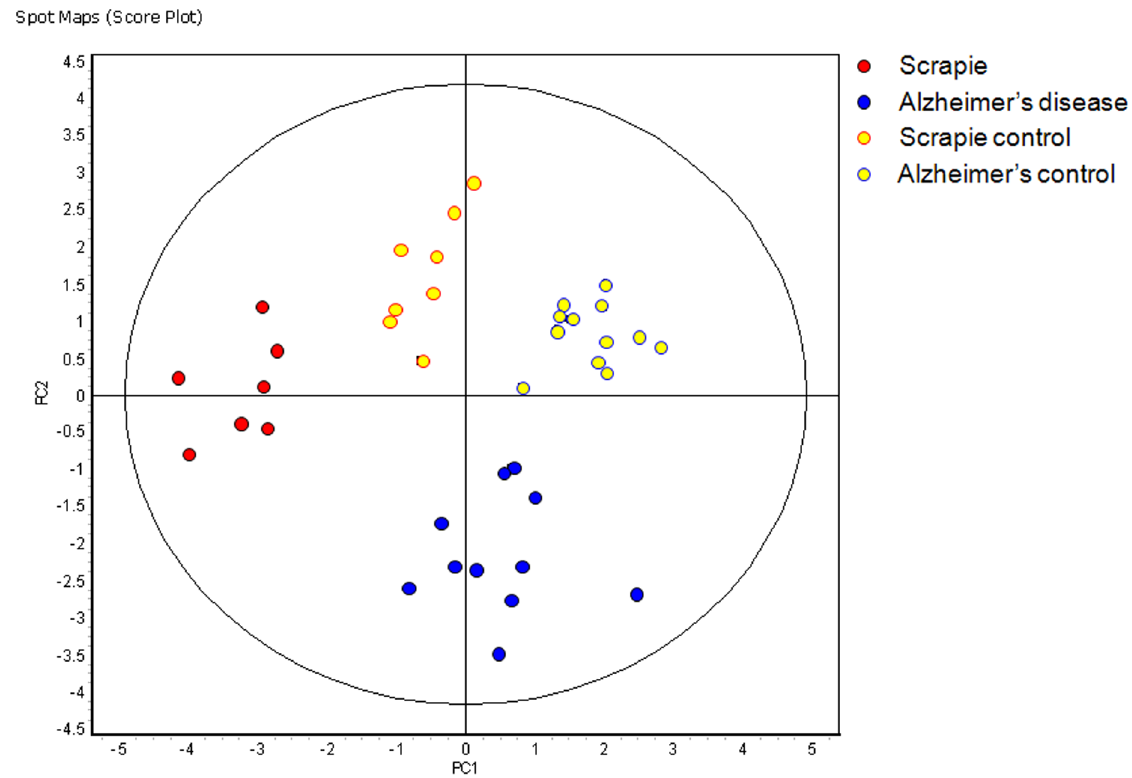
Figure 4. Principle component analysis of the 169 feature classifier applied to the 7 scrapie infected (red) and the 8 corresponding scrapie control samples (yellow with red boarder) obtained from 4 infected and 4 control mice at 15 and 17 weeks post infection combined with the 11 Alzheimer’s diseased (blue) and the 12 corresponding Alzheimer’s disease control samples (yellow with blue boarder) obtained from 4 diseased and 4 control mice at 32, 36 and 40 weeks of age. (PC1=27.9, PC2=24.5).